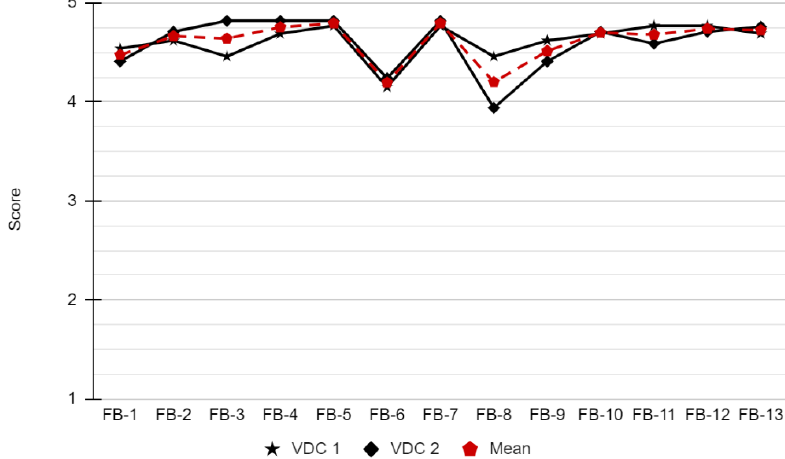
Fig. 8. Survey results on feedback from VDC I and VDC II